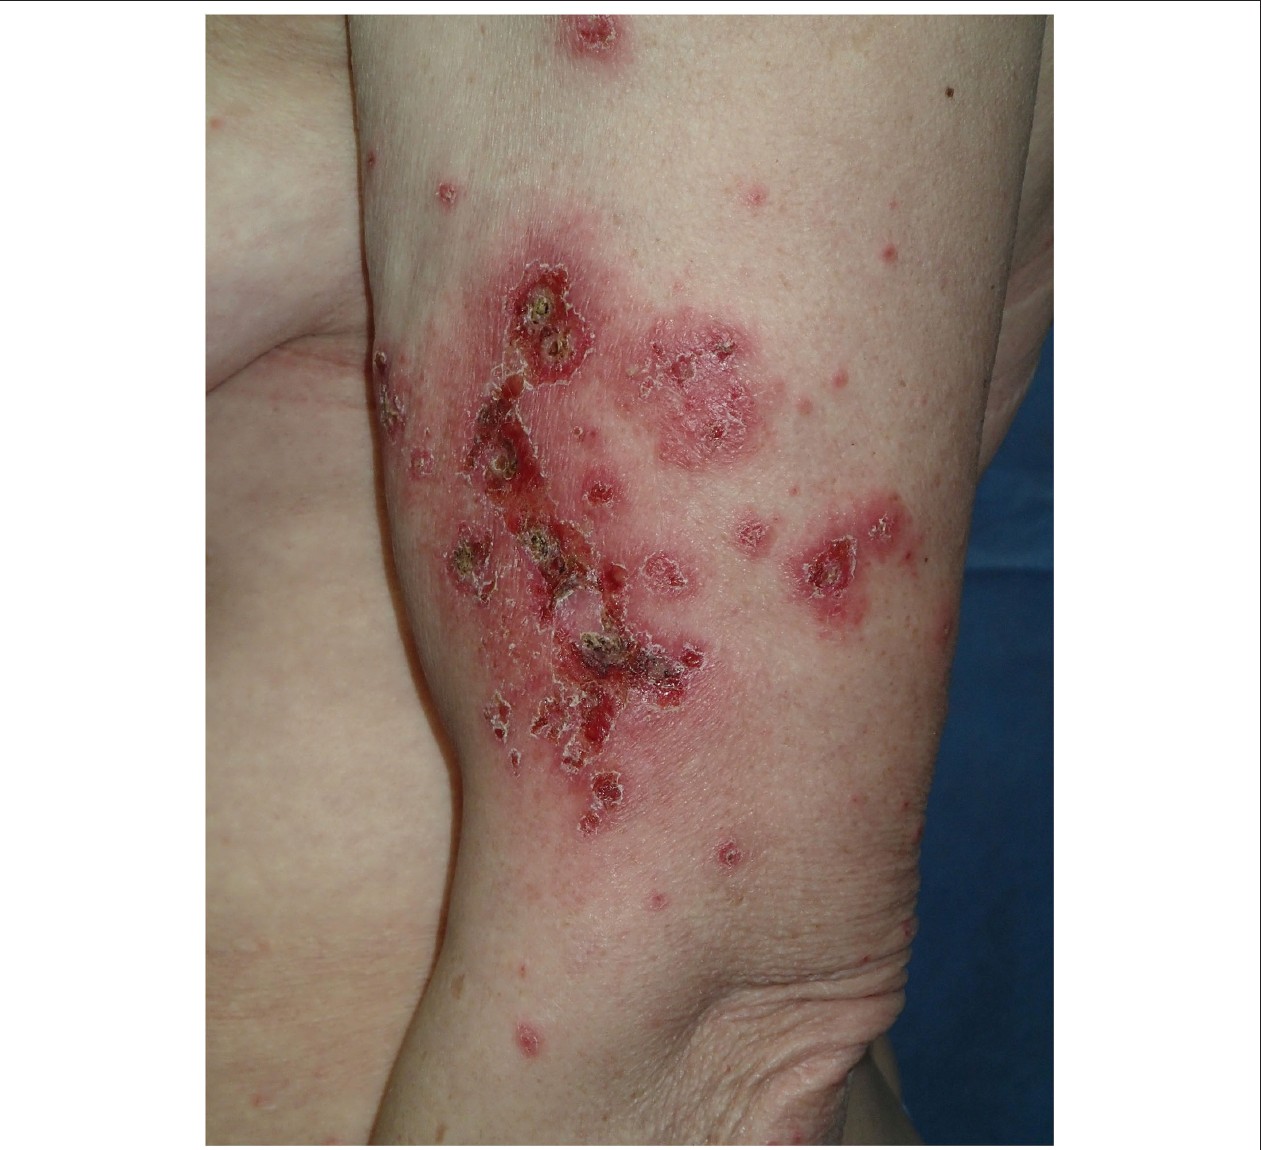
FIGURE 1 | Annular-polycyclic photosensitive eruption of subacute cutaneous lupus erythematosus (SCLE) occurring after COVID-19 illness; note the trailing scale in the periphery of the